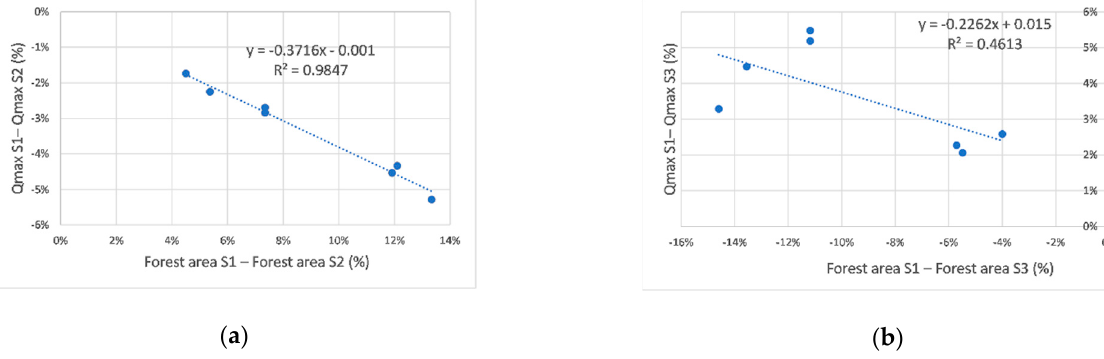
Figure 16. Comparative analysis for the maximum value of water flow during events and differences in forested areas, between the three scenarios S1, S2 and S3. ( a ) S1 compared with S2; ( b ) S1 compared with S3.